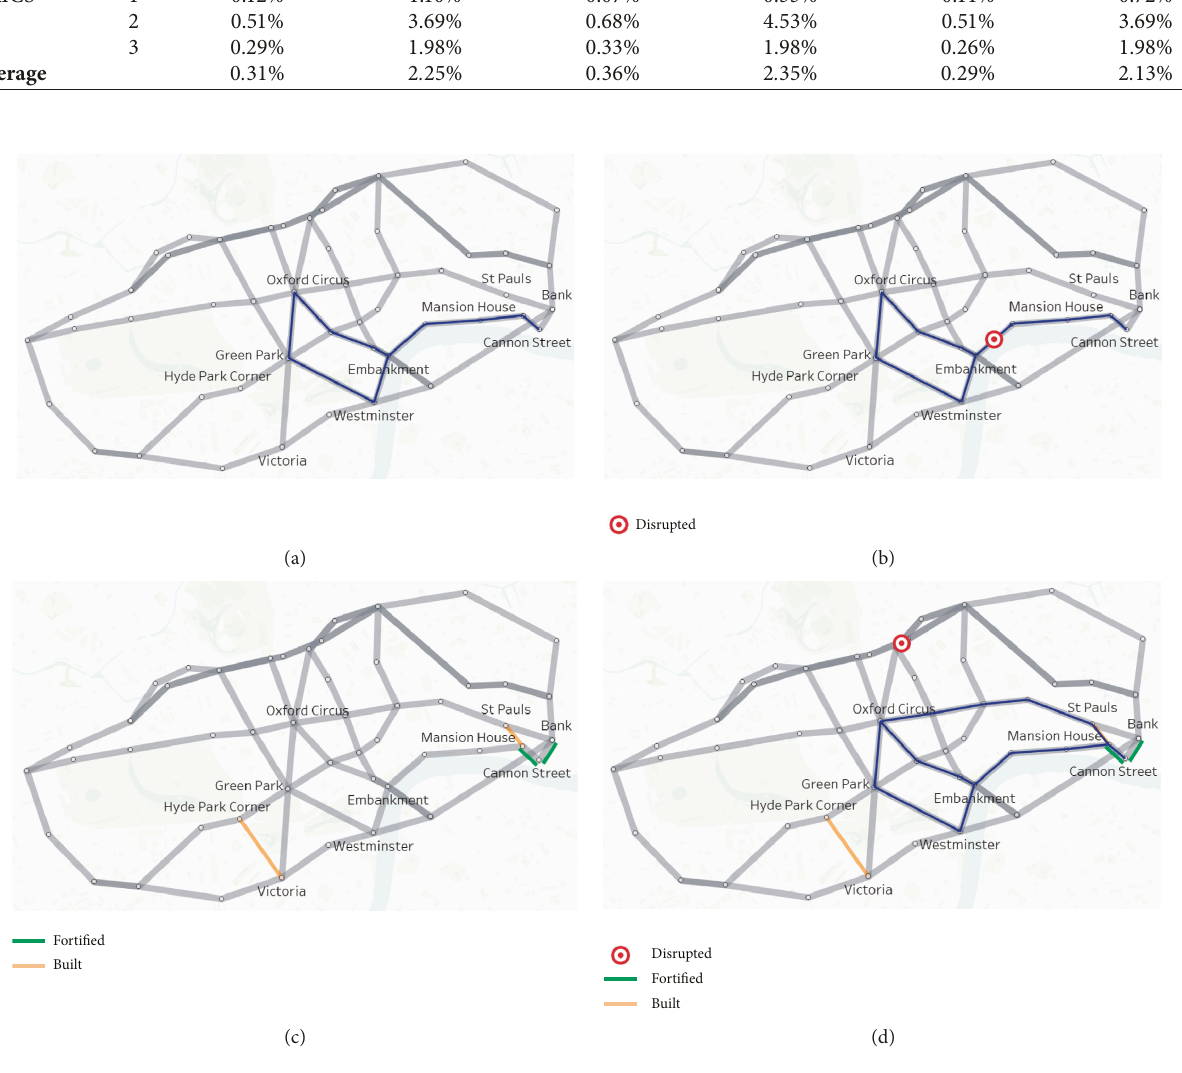
Figure 11: (a) Bond Street to Mansion House, u � 0; s � 0, t � 0. (b) Bond street to mansion house, u � 1; s � 0, t � 0. (c) Forti_cation and protections, u � 1; s � 2; t � 2. (d) Bond street to mansion house, u � 1; s � 0, t �